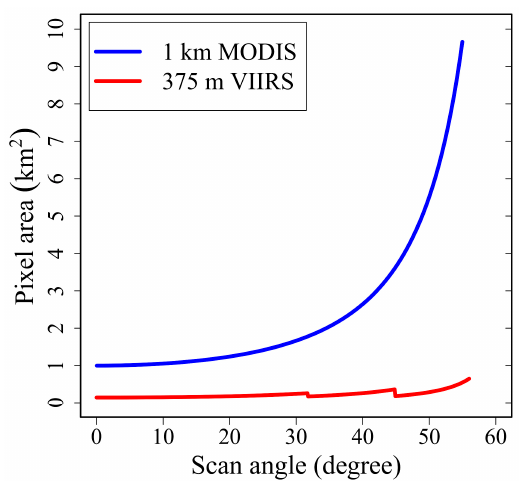
Figure 1. Variation of the area of a Moderate Resolution Imaging Spectroradiometer (MODIS) (blue line) and VIIRS I-band (red line) pixel along the scan angle from nadir to the scan